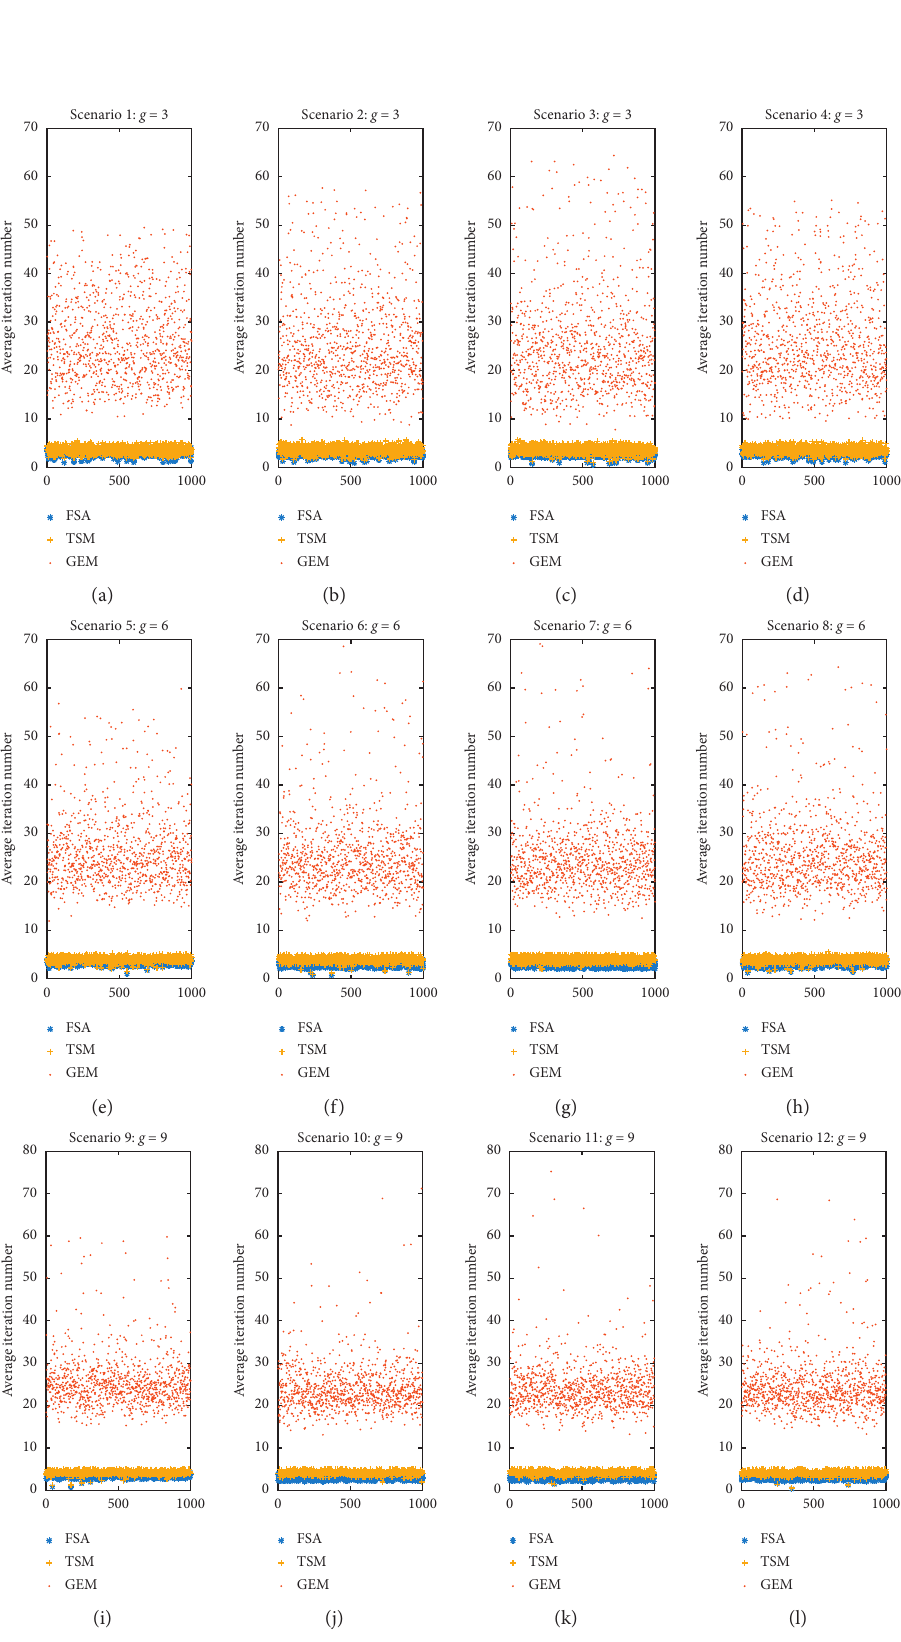
Figure 1: Number of iteration of algorithms for global MLEs from 1000 parameter